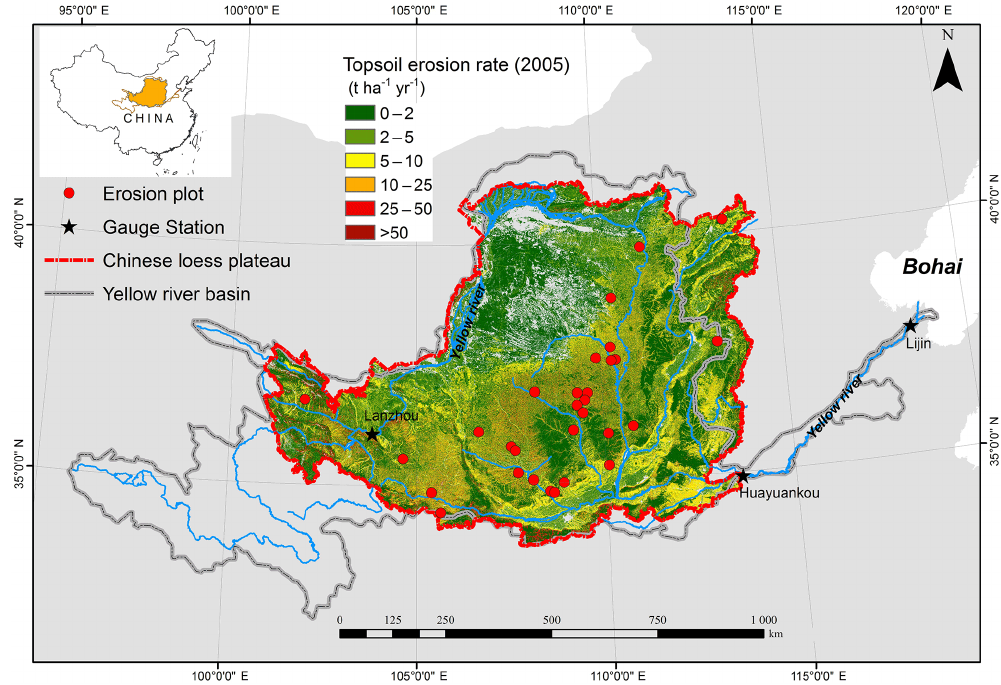
Figure 1. Topsoil erosion map of the Chinese loess plateau calculated from our model (Eq. 2) with an indication of the location of the erosion plots used in this